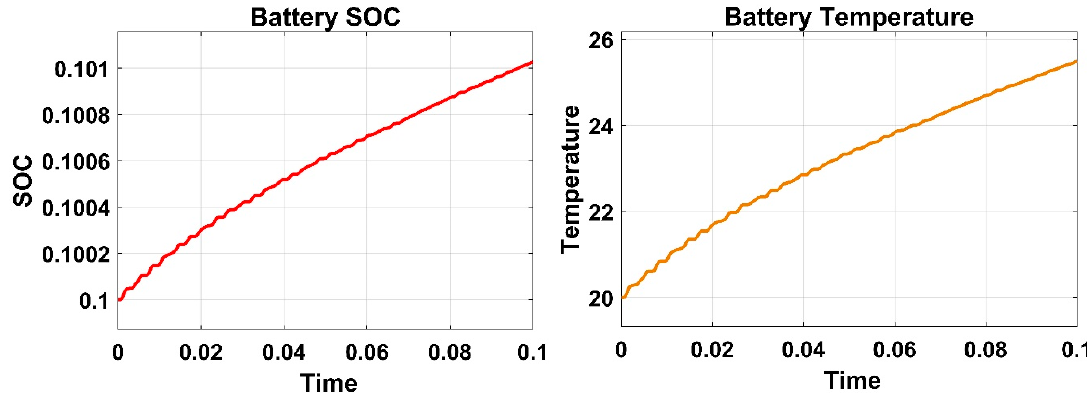
Figure 2. Battery current, voltage, state of charging and temperature in case of slow charging.